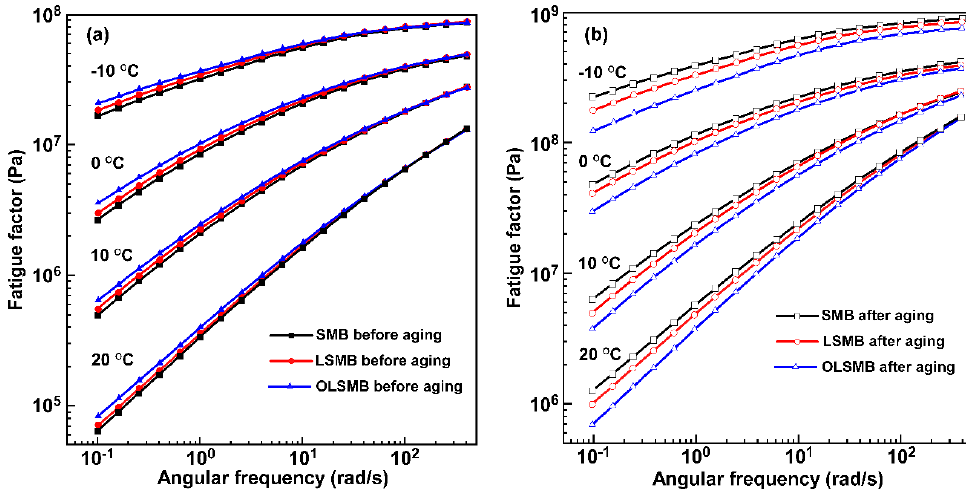
Figure 7. Fatigue factor vs. frequency for SMB, LSMB and OLSMB ( a ) before and ( b ) after